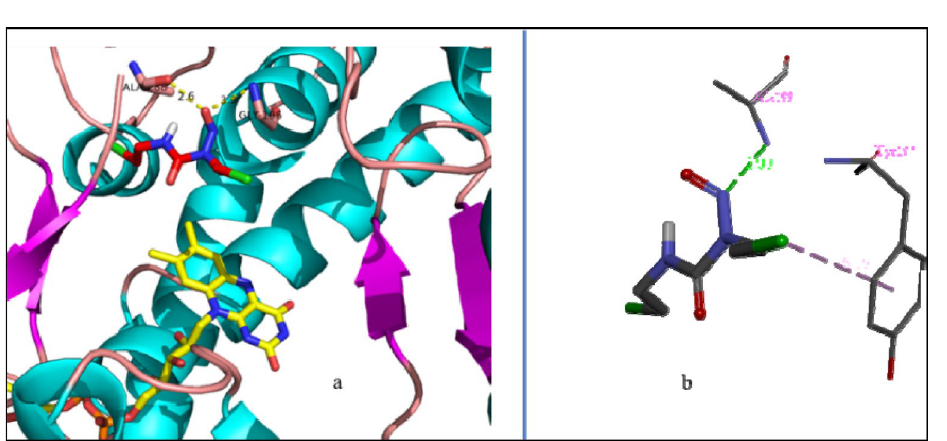
Figure 3. Carmustine interaction at the ligand binding site post docking calculations ( a ) At active site ( b ) interaction of carmustine with